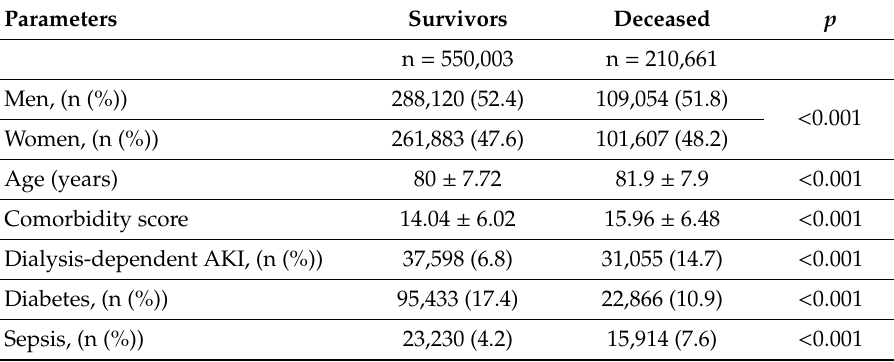
Table 3. Comparison of survivors and deceased individuals with acute kidney